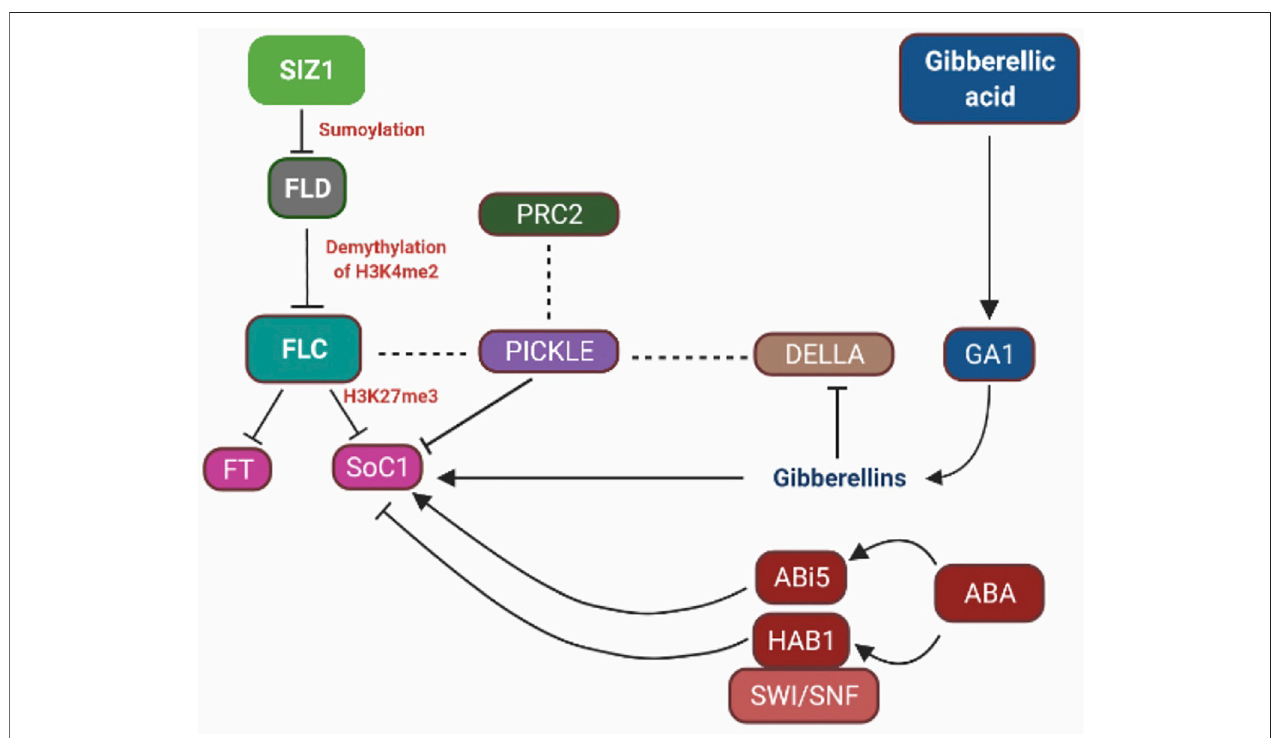
FIGURE3| Epigeneticcontrolonphytohormones:DELLAproteinsarenegativeregulatorsofSOC1.DELLAproteinsincombinationwithFLCinteractwithPICKLE (chromatin-remodelingprotein)andPRC2andrepresstheexpressionofSOC1.PRC2regulatesGAsignalingbyincreasingH3K27me3-repressinghistoneprotein.ABA INSENSITIVE MUTANT 5 overexpression delays fl owering initiation by upregulating the expression of FLC. ABA HYPERSENSITIVE 1 (HAB1) is a negative regulator of fl oweringwhencombinewiththechromatin-remodelingcomplexSWI/SNF.FLCisnegativelyregulatedbylysine-speci fi cdemethylase1 – typehistonedemethylase (FLD). FLD causes demethylation of H3 histone (H3K4me3) in FLC. FLC downregulates SOC1 expression by trimethylation of lysine 27 on histone H3 protein via the formation of heterochromatic regions. SUMO E3 ligase (SIZ1) promotes expression of FLC by facilitating repression of FLD through sumoylation.